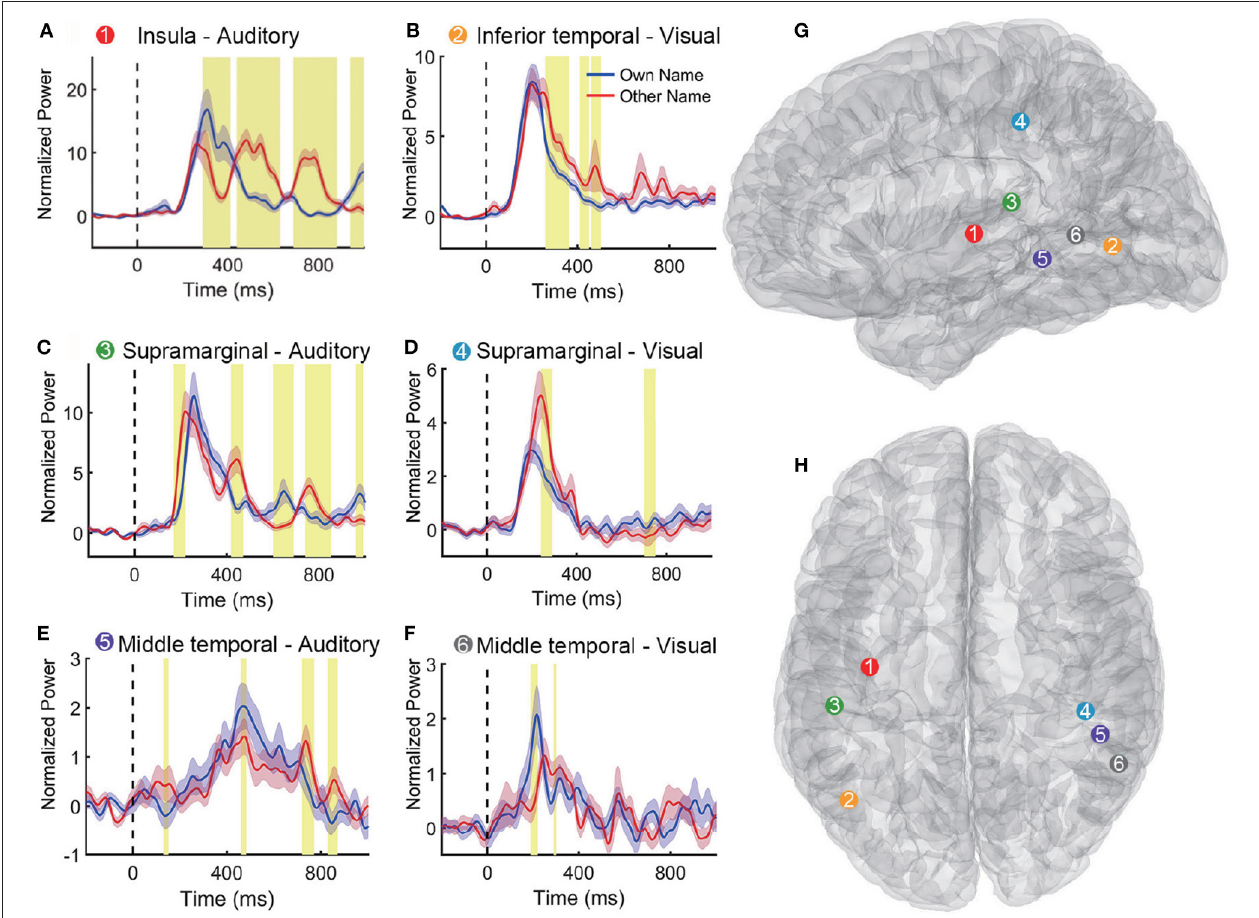
FIGURE 5 | Representative high-gamma-power traces following own and other name presentation. (A–F) Shows responses to the two names in different contacts. The blue and pink shaded region represents the standard error across trials. The intervals highlighted with yellow indicate that there were significant differences between the two responses ( p < 0.05). Vertical dashed lines (Time = 0 ms) indicate the stimulus onset. (G,H) Show six contact locations in the sagittal and transverse view of the standard MNI brain model. The response traces in (A–F) and the corresponding contact locations in (G,H) are matched with different numbers and